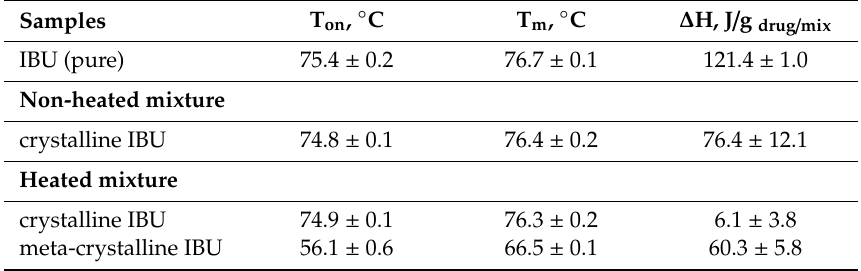
Table 2. Summary of DSC analysis of 20% w / w IBU-CLAD